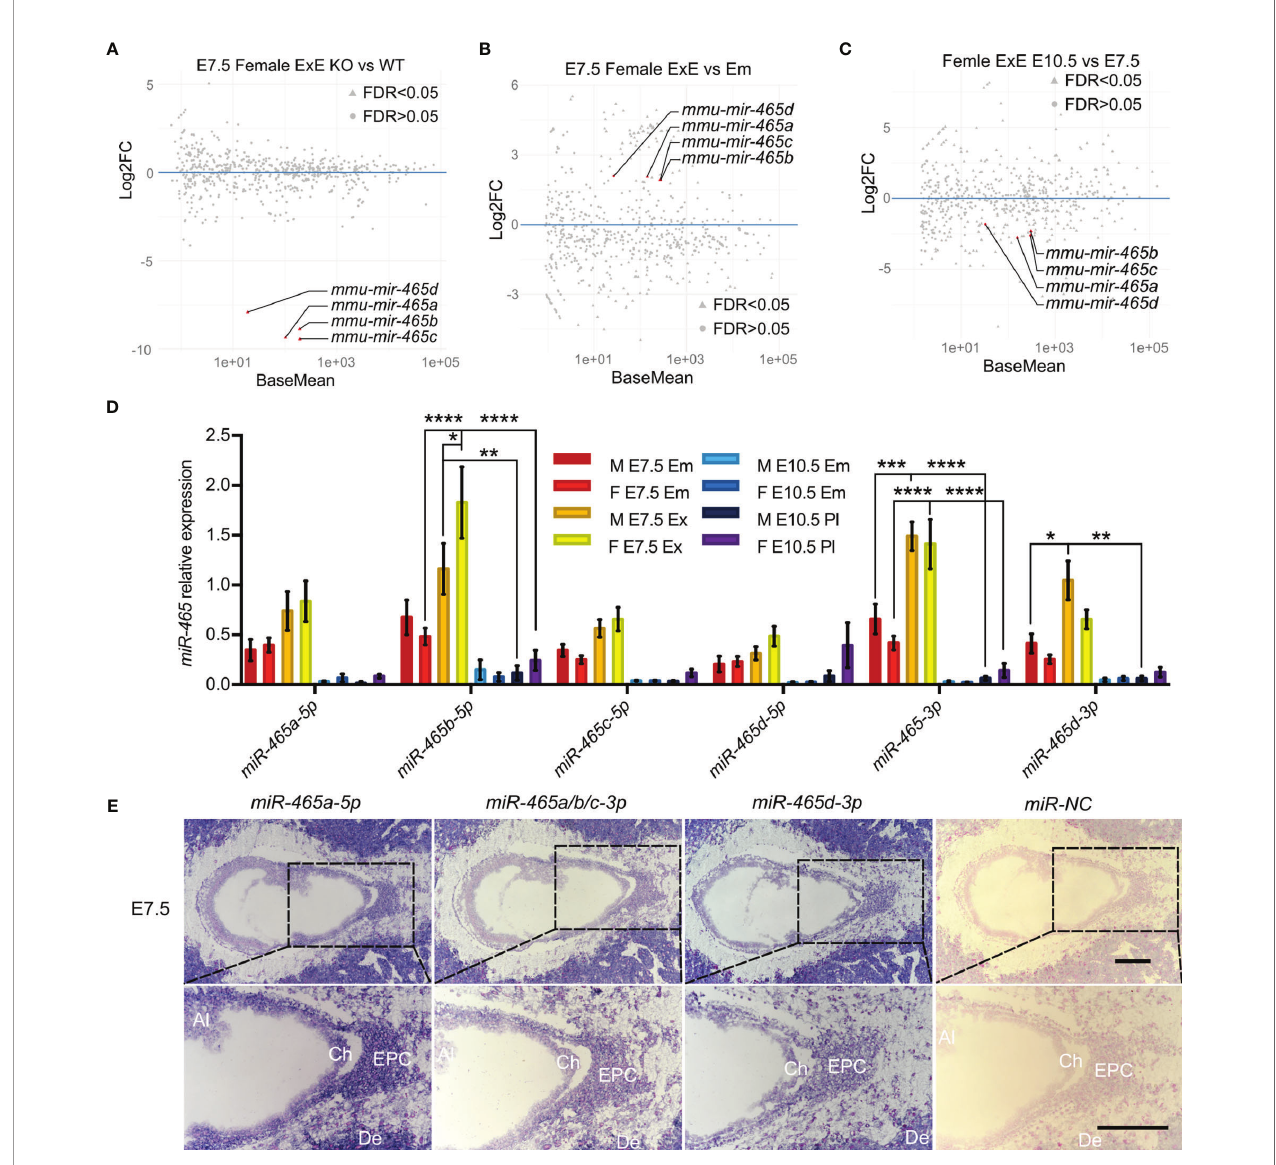
FIGURE 3 | Expression pro fi les of the miR-465 cluster. (A) Differentially expressed miRNAs between WT and KO female extraembryonic tissues at E7.5. (B) Differentially expressed miRNAs between WT female extraembryonic tissues and embryos at E7.5. (C) Differentially expressed miRNAs between WT female extraembryonic tissues/ placentas at E7.5 and E10.5. Data points representing the miR-465 cluster miRNAs are marked in red. sRNA-seq analyses were conducted in biological triplicates (n=3). (D) TaqMan qPCR analyses of expression levels of the miR-465 cluster miRNAs in extraembryonic tissues/placenta and embryos at E7.5 and E10.5. M, male; F, female; Em, embryo; ExE, extraembryonic tissue; Pl, placenta. *, p<0.05; **, p<0.01; *** p<0.001, **** p<0.0001. (E) Representative miRNA-ISH results showing localization of the miR-465 cluster miRNAs in female conceptuses at E7.5. Ch, chorion; EPC, ectoplacental core; Al, allantois; De, decidua. Scale bars = 200